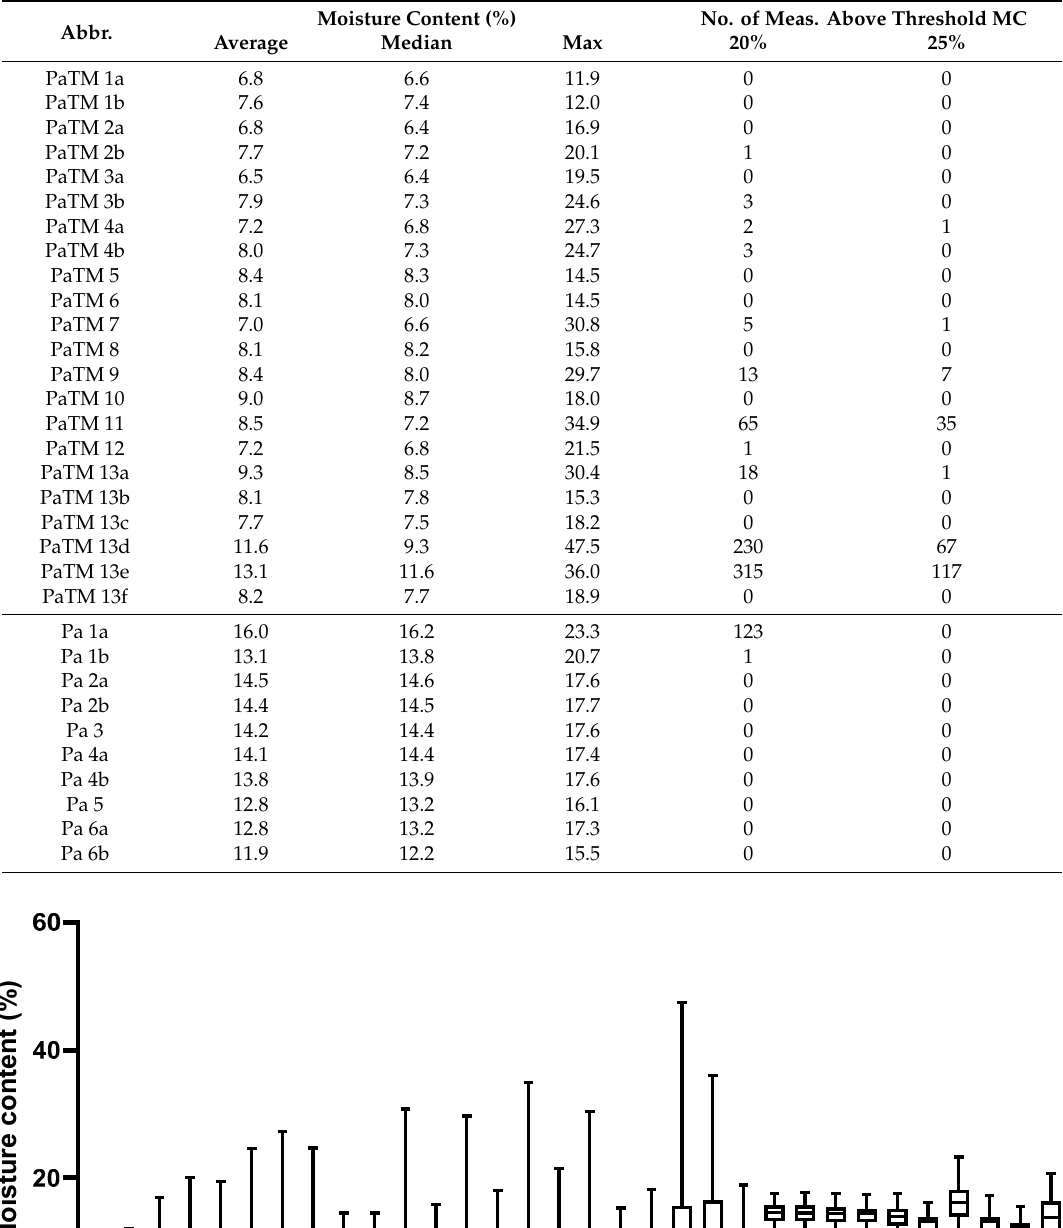
Table 2. Wood moisture content data in the locations of the building at which monitoring was performed between 13th of July 2016 and 15th of July 2019. Abbreviations are the same as in Table 1. Moisture Content (%) No. of Meas. Above Threshold MC Abbr. Average